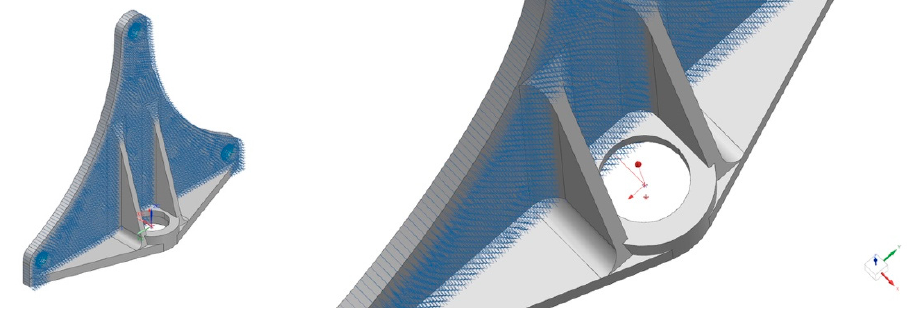
Figure 6. FEM constraints.